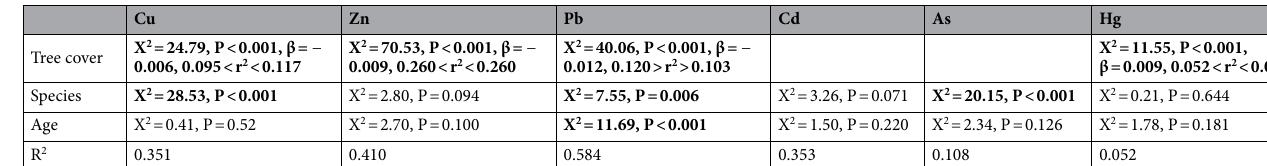
Table 1. Results of the best fitting statistical models testing the link between MTE concentrations (Cu, Zn, Pb, Cd, As and Hg) and urbanization level (here tree cover) while taking into account the species, the age and the location, tested in 8 cities and 4 protected forests. Degrees of freedom were 1 for all the variables. The proportion of the variance in MTE concentrations that is explained by the urbanization level—r 2 —is comprised between two values computed from the metrics “first” and “last” 57 . For Hg, the random effect “city” had a zero variance, preventing to calculate the coefficient of determination—R 2 —of the model; for this reason, we report for Hg the adjusted coefficient of determination from the linear model. Significant effects (P < 0.05) are highlighted in bold. Results are strikingly similar when using impervious surface cover and urbanization score as metric for urbanization quantification; these are reported in Table